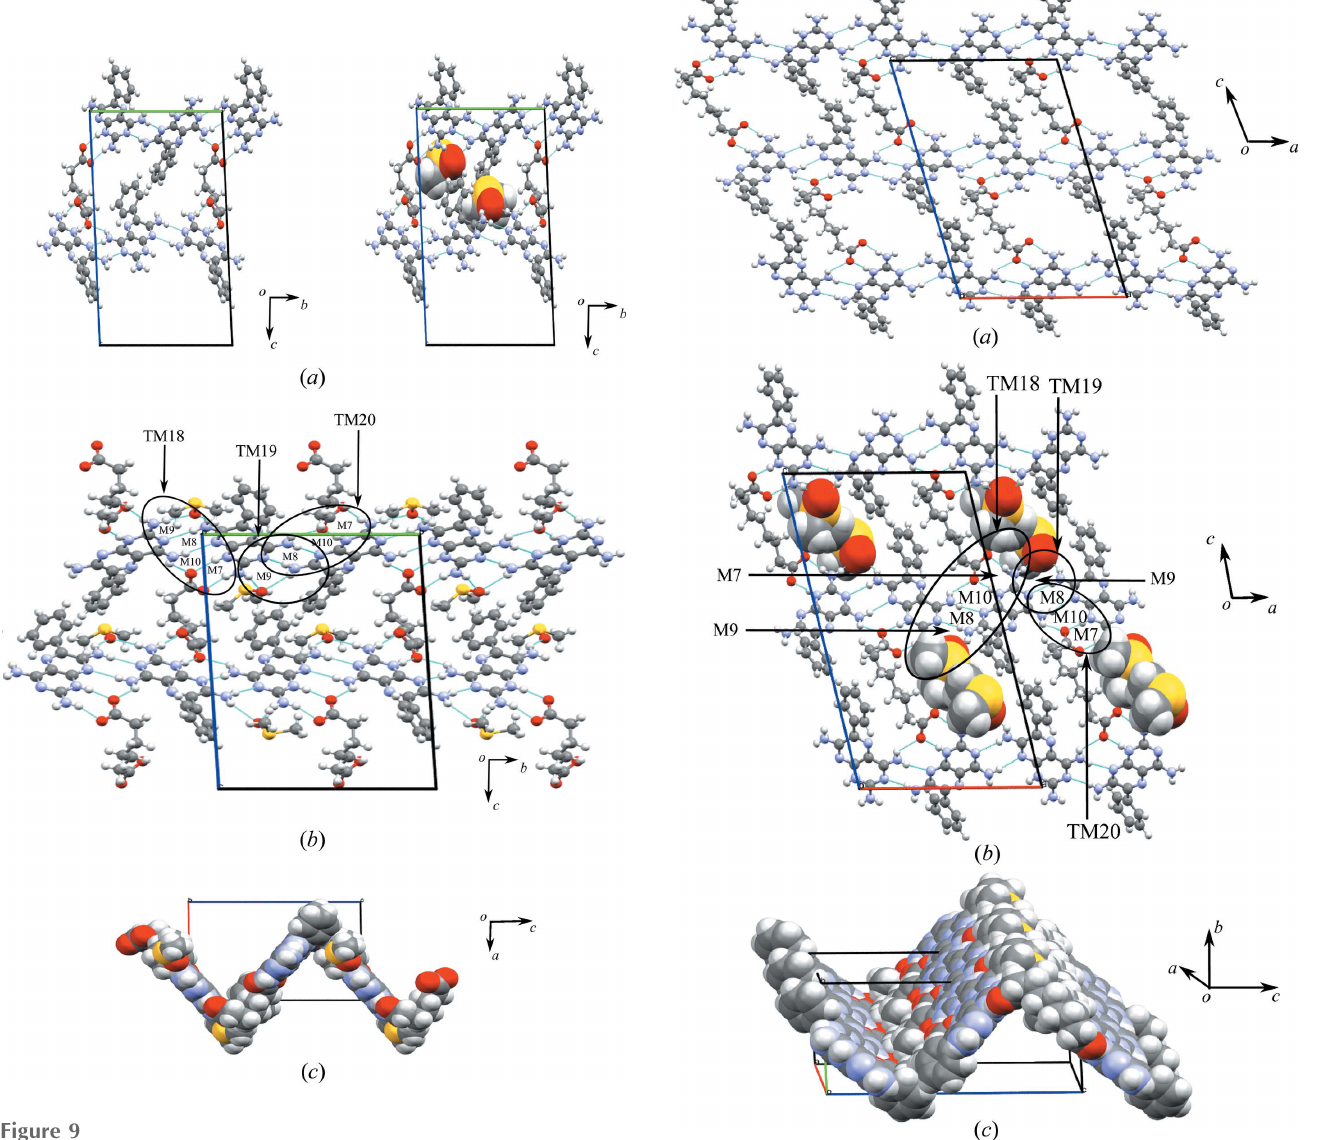
Figure 9 ( a ) The eight-membered hydrogen-bonded host network with a cavity of 14.9 (cid:8) 9.1 A˚ and the same cavity filled with two DMSO molecules as guests. ( b ) Motifs M7, M10, M8 and M9 (TM18), M8 and M9 (TM19), and M7, M10 and M8 (TM20) found in the sheet structure formed by the host–guest hydrogen-bonded network. ( c ) The zigzag nature of the sheet structure seen in 1d (cid:3)